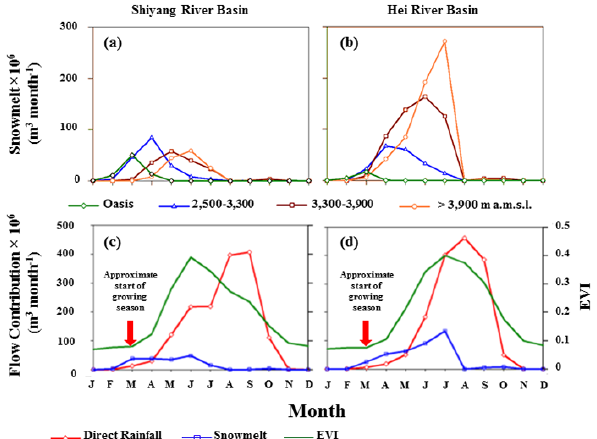
Figure 8. Ten-year mean monthly snowmelt generated within the different elevation zones (a, b) and mean monthly contribution of rainwater and snowmelt to the monthly river runoff from the Qil- ian Mountains (based on previous work by Matin and Bourque, 2015) and corresponding monthly enhanced vegetation index for the Shiyang (c) and Hei river basins (d) for the 2000–2009